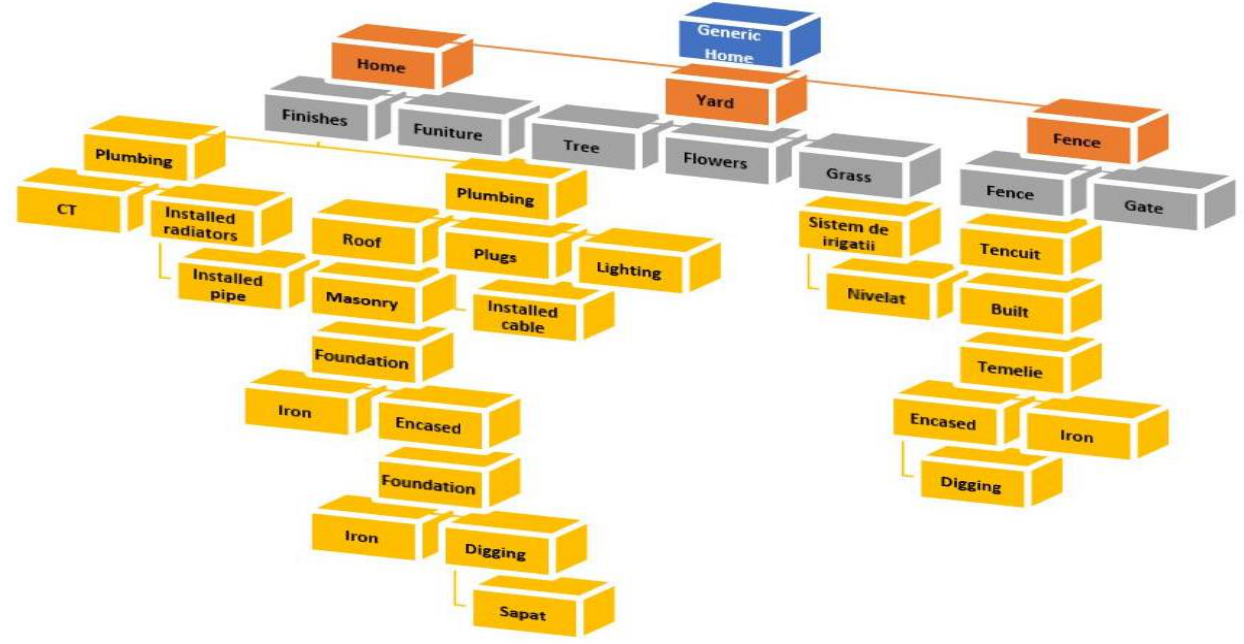
Figure 3. Conceptual diagram of the database dedicated to the Coestim planner, adapted from [34].